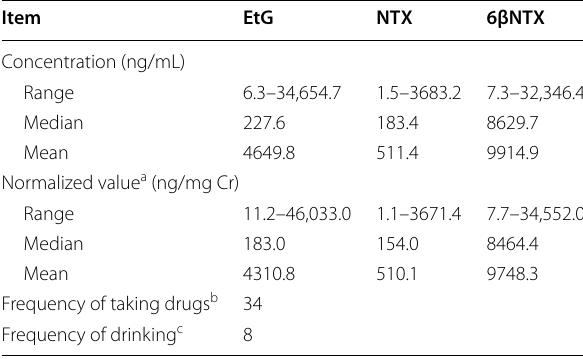
Table 6 Quantification of EtG, NTX, and 6βNTX in urine samples from alcohol abusers ( n =